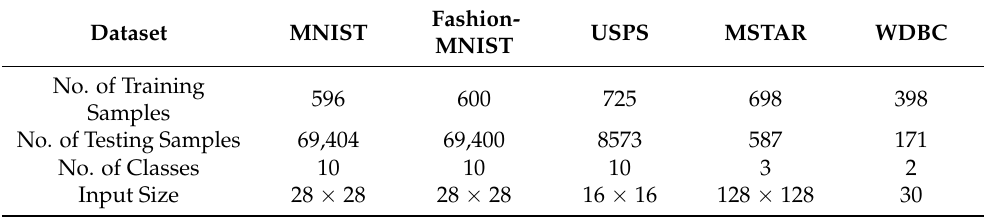
Table 1. The number of training and testing samples, number of classes, and input sizes for each dataset.